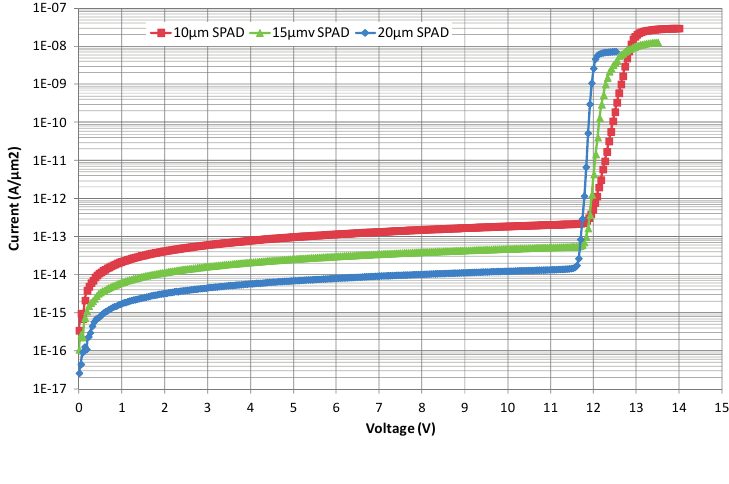
Figure 4. Current versus voltage as a function of area for 3 photodiodes (10, 15 and 20